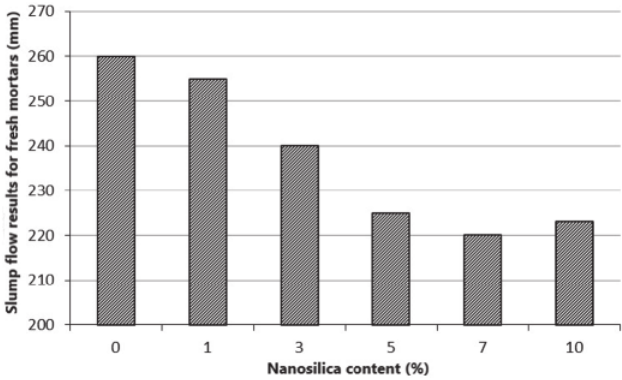
Figure 1 Mortars flowability with different contents of nS Source: Adapted from EL-BAKY; YEHIA; KHALIL [9] Figure 2